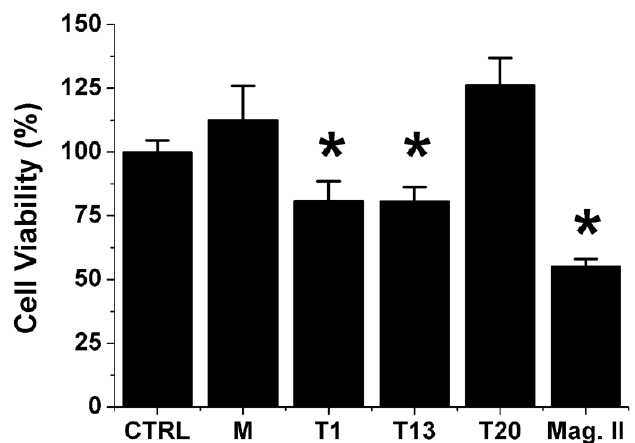
Figure 4. Neurotoxicity results obtained in HT22-DIFF neuronal cells, relative to sCT solutions representative of the “Lag-phase” (T1), “Growth-phase” (T13) and “Saturation-phase” (T20). Result relative to Magainin II (Mag. II) is also reported. CTRL represents the treatment with the vehicle solution (PB at 5 mM). Error bars represent the standard error ( N = 4) and * indicate p < 0.05.